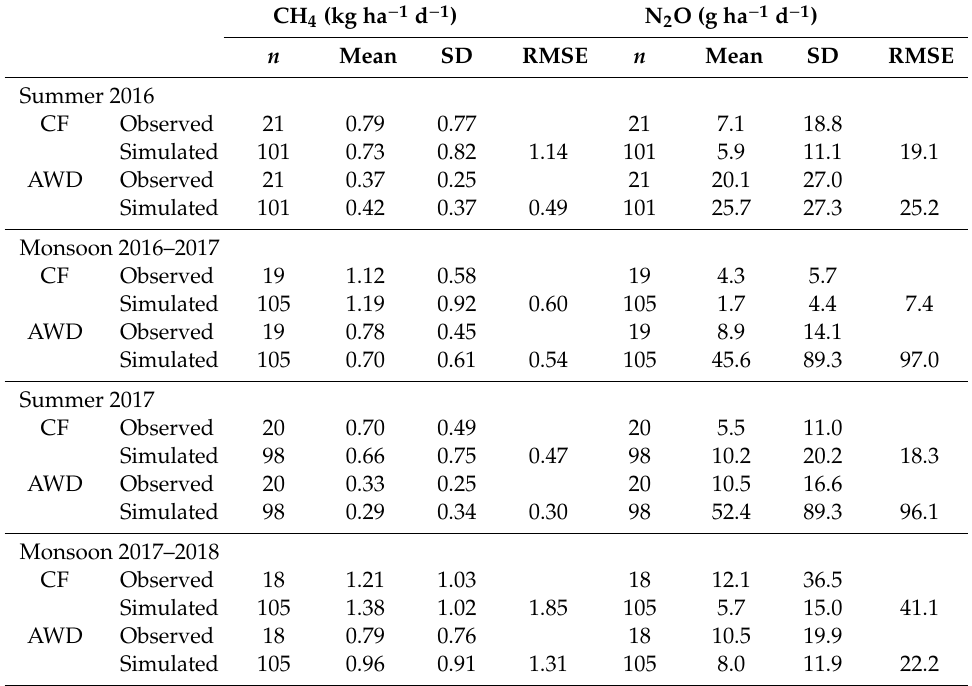
Table 3. Observed and simulated mean CH 4 and N 2 O fluxes from rice fields under continuous flooding (CF) and alternate wetting and drying (AWD) conditions during di ff erent rice-growing seasons. n —number of samples, SD—standard deviation, RMSE—root mean square